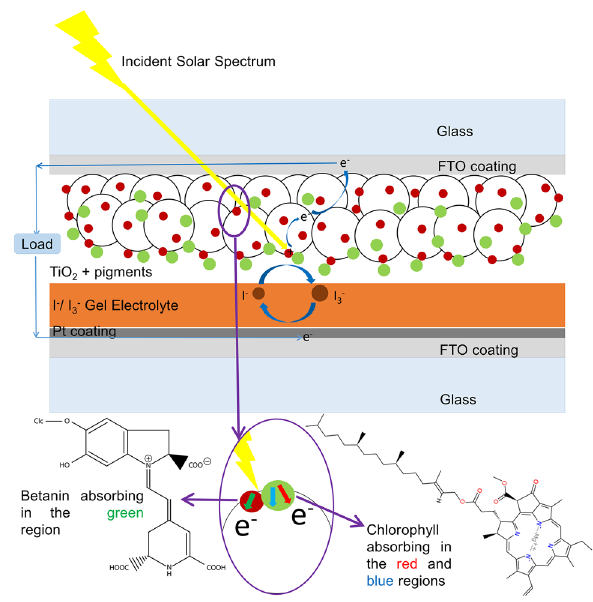
Fig. 1 Schematic representation of the device showing the comple- mentary absorption by the co-sensitized pigments betanin and chlo-